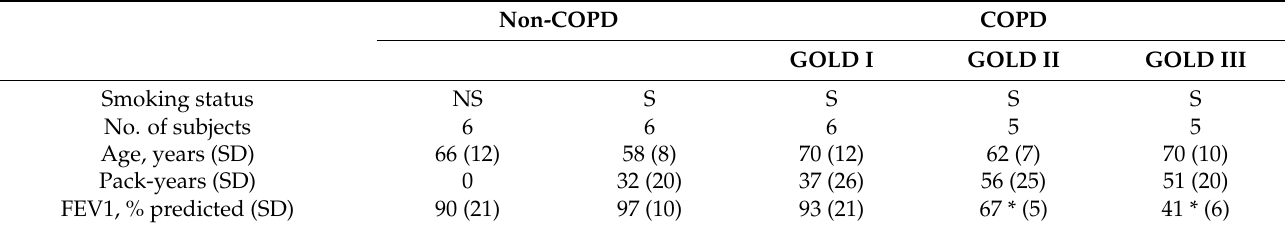
Table 1. Clinical characteristics of